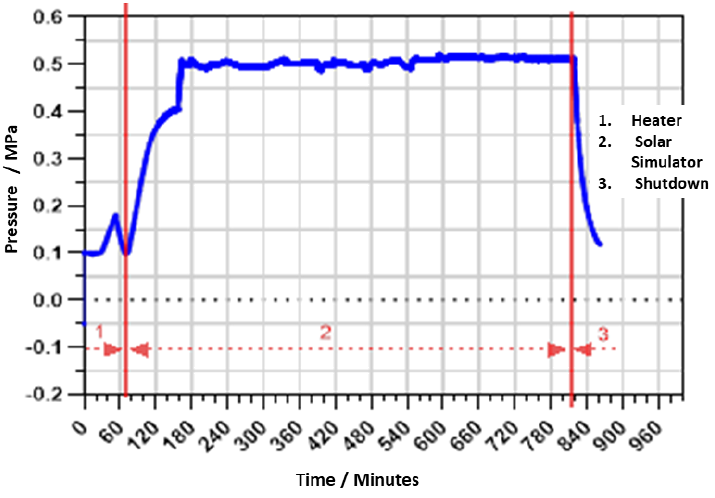
Figure 7. Pressure against time plot showing steady−state.